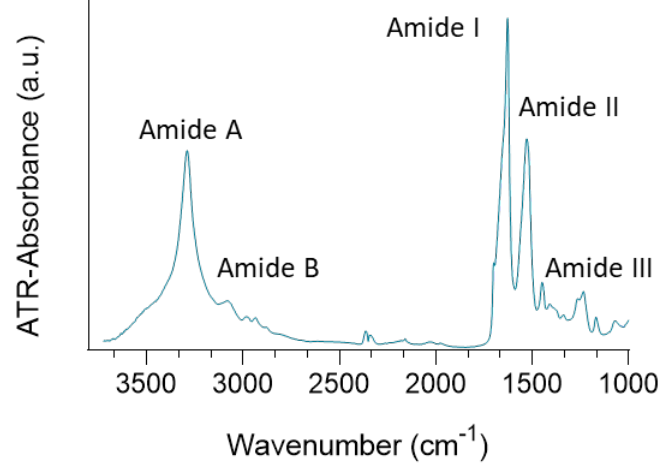
Figure 3. ATR − FTIR spectra of SF fibre.